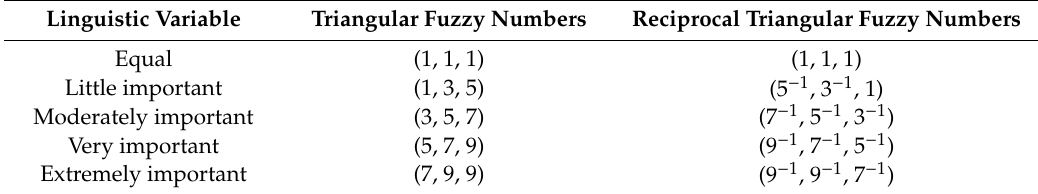
Table 1. Membership function of fuzzy